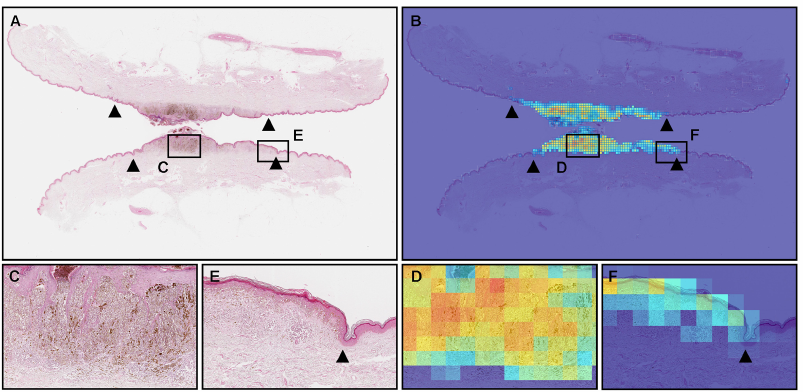
Figure 3. An example of the true positive predictions of melanoma; consistent with the distribution of the melanoma lesion as indicated by the pathologist (black triangles) ( A ), the heatmap image ( B ) shows the true positive predictions of the melanoma area. The model ( × 20, 512 × 512 px) predicted satisfactorily melanoma cells, including melanin ( C , D ). In the marginal area ( E , F )), the model ( × 20, 512 × 512 px) could detect a small number of melanoma cells. Red indicates a high probability and blue indicates a low probability.